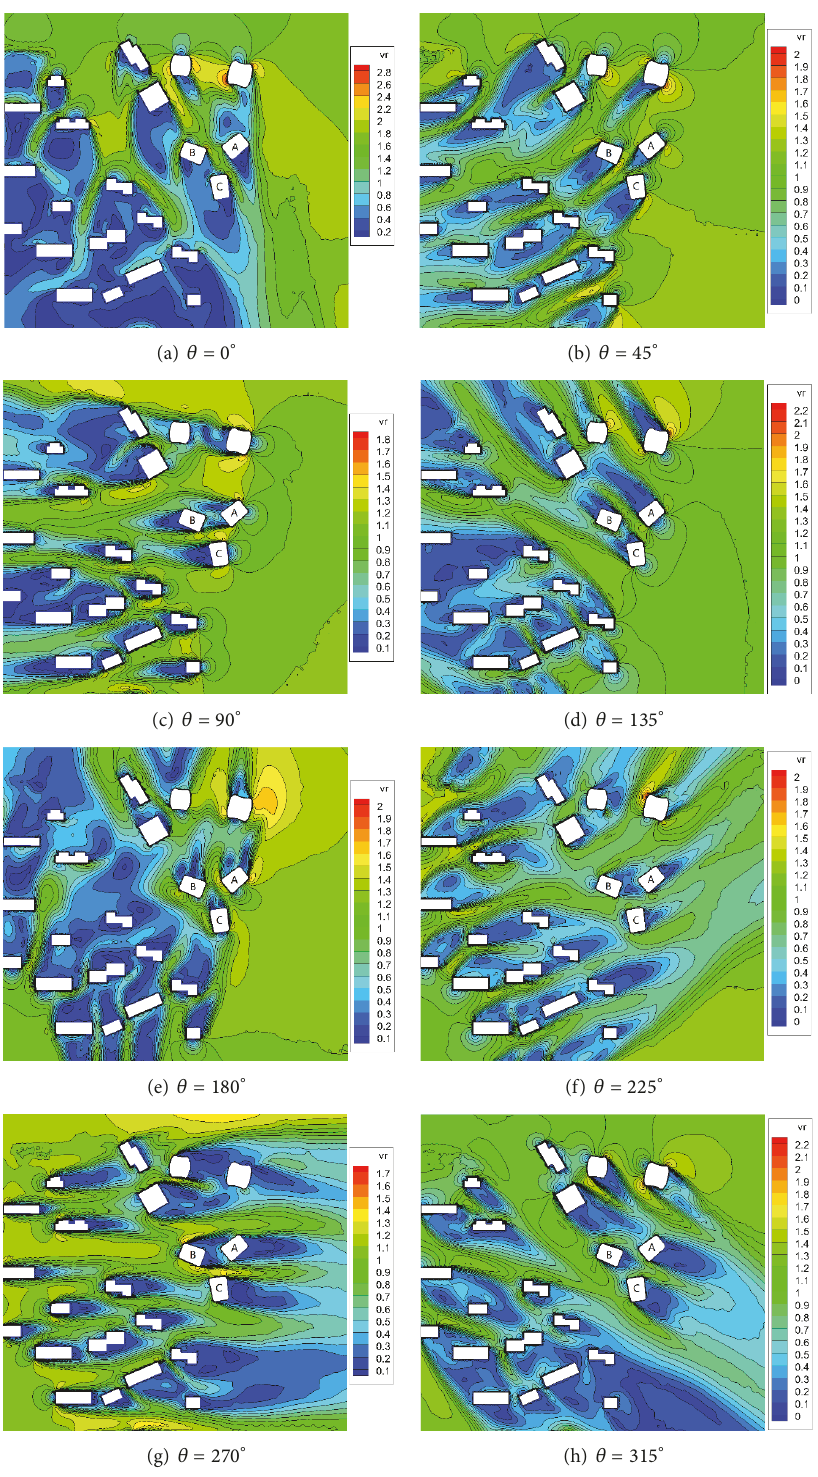
Figure 6: Contours of the wind speed ratio distribution around the buildings at typical wind angles ( 𝜃